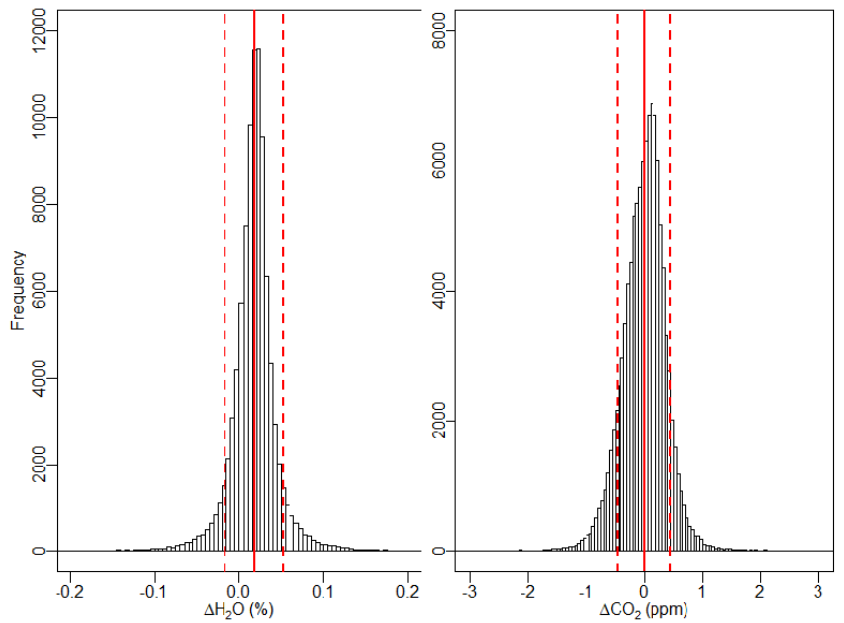
Figure 9. Histogram of the difference between H 2 O and CO 2 mixing ratios from FCHAOS and the Picarro G2301-f. FCHAOS CO 2 has been calibrated, while H 2 O has not. For H 2 O, there is a mean of 0.018% or 180ppm, median of 0.018% or 180ppm, and 1 σ of 0.034% or 340ppm, for which Picarro G2301-f precision is 100ppm. For CO 2 , there is a mean of 0ppm, median of 0.024ppm, and 1 σ of 0.45ppm.